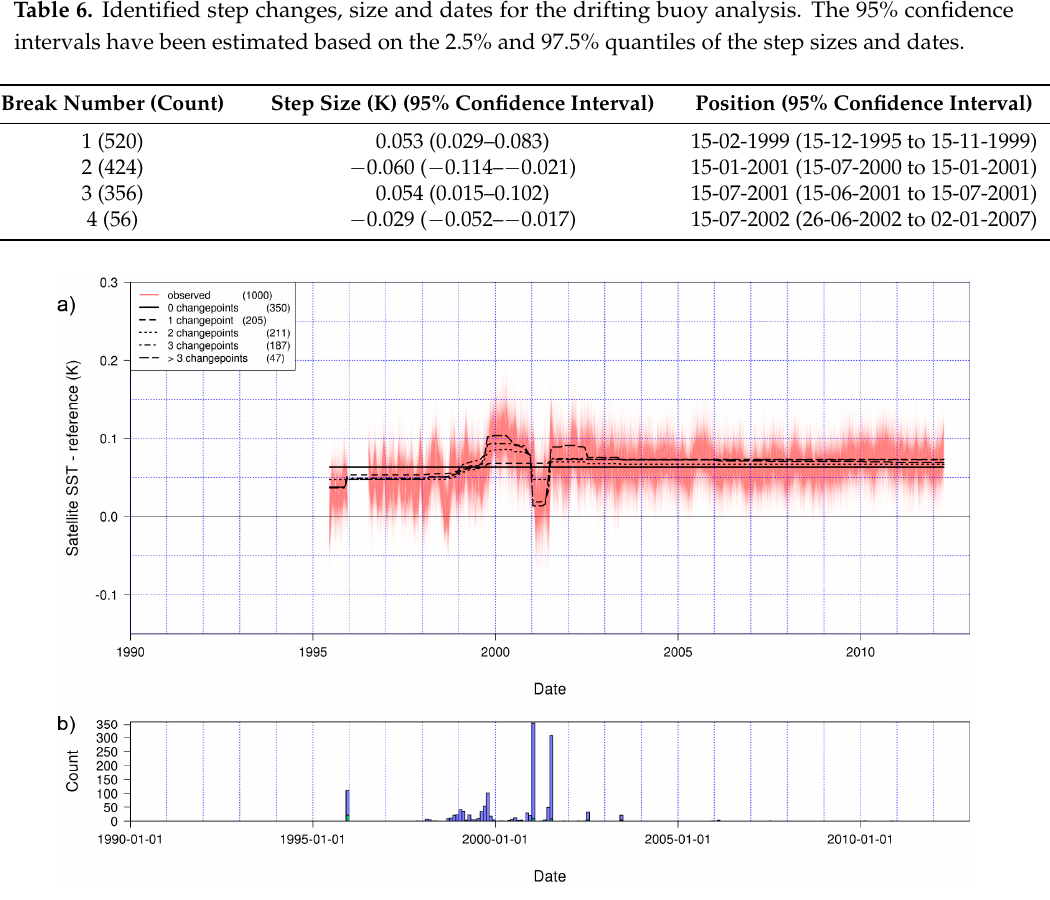
Table 5. As Table 4 but for the drifting buoy analysis.